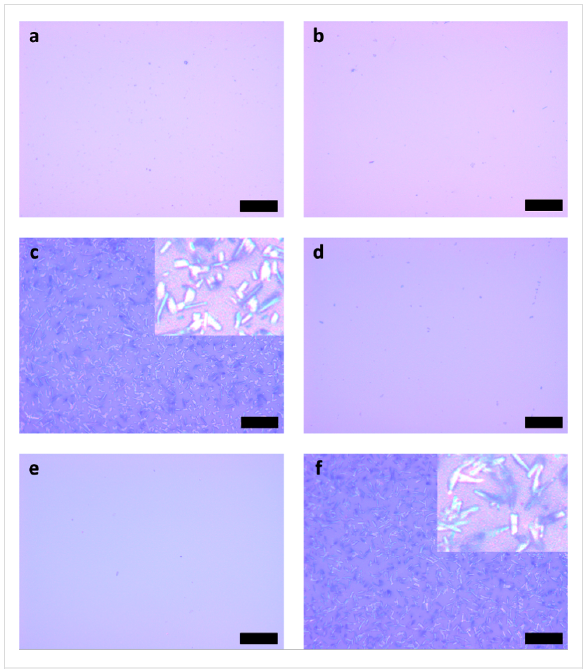
Figure 2: Optical micrographs for molecular thin films grown on glass substrates. (a) α -MnPc film grown at room temperature. (b) MnPc film annealed at 270 °C without cover. (c) β -MnPc film formed by annealing of the α -MnPc sample at 330 °C with cover. (d) MnPc:TCNQ film grown at room temperature. (e) MnPc:TCNQ film annealed at 270 °C without cover. (f) β -MnPc film formed by annealing of a MnPc:TCNQ sample at 270 °C with cover. The scale bars correspond to a length of 20 µm for the images and 5 µm for the insets.